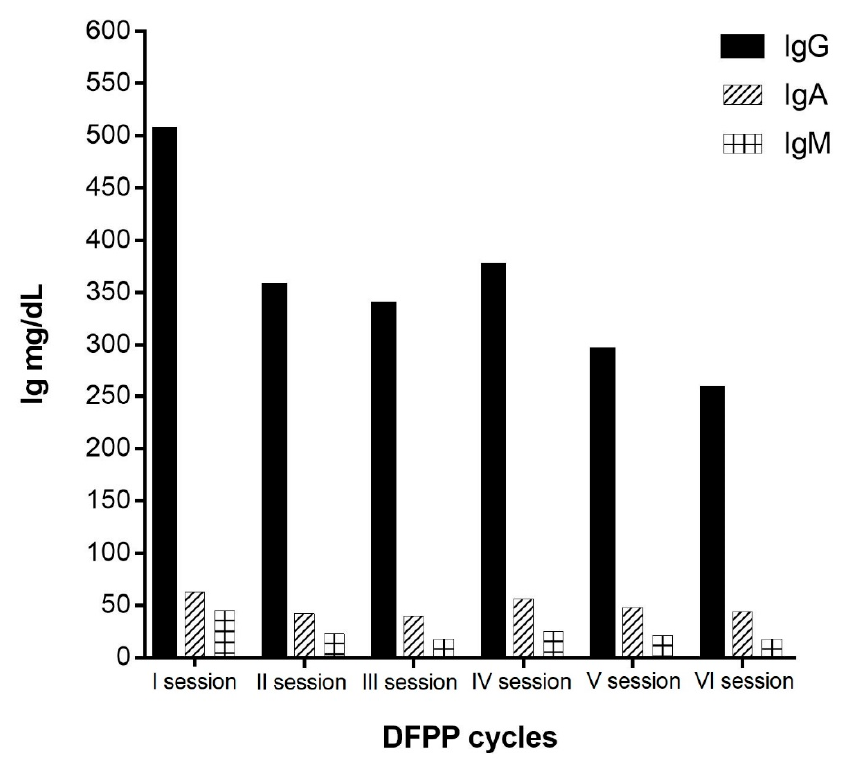
Figure 3. Immunoglobulin G (IgG), A (IgA), and M (IgM) concentrations during DFPP cycles.